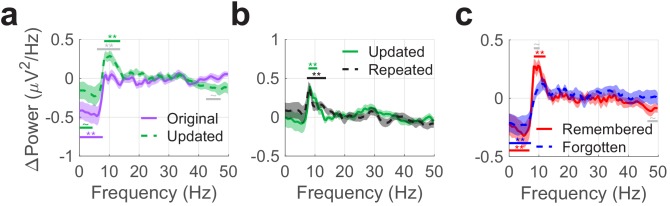
Theta phase resets follow fixations to objects and predict subsequent memory.Each panel depicts differences in mean ERP power post- vs. pre-fixation to identify phase alignment across trials. (a) Phase resets occurred following fixations to updated vs. original object-locations from 8 to 13 Hz. On the other hand, ERP power was slightly greater for fixations to the original object-location during the pre-fixation period between 0.5 to 4 Hz. (b) The magnitude of phase resets was consistent following fixations to objects presented in updated and repeated viewing conditions. (c) Phase resets following fixations to updated object-locations were associated with intact memory for the original object-location. Colored bars denote significant differences vs. zero for each condition. Grey bars denote significant differences between conditions. Shaded regions denote standard error of the mean (across subjects). **
PFWE < 0.05, ~ PFWE < 0.1.Figure 4—figure supplement 2—source data 1.MATLAB code and source files to reproduce data in Figure 4—figure supplement 2.